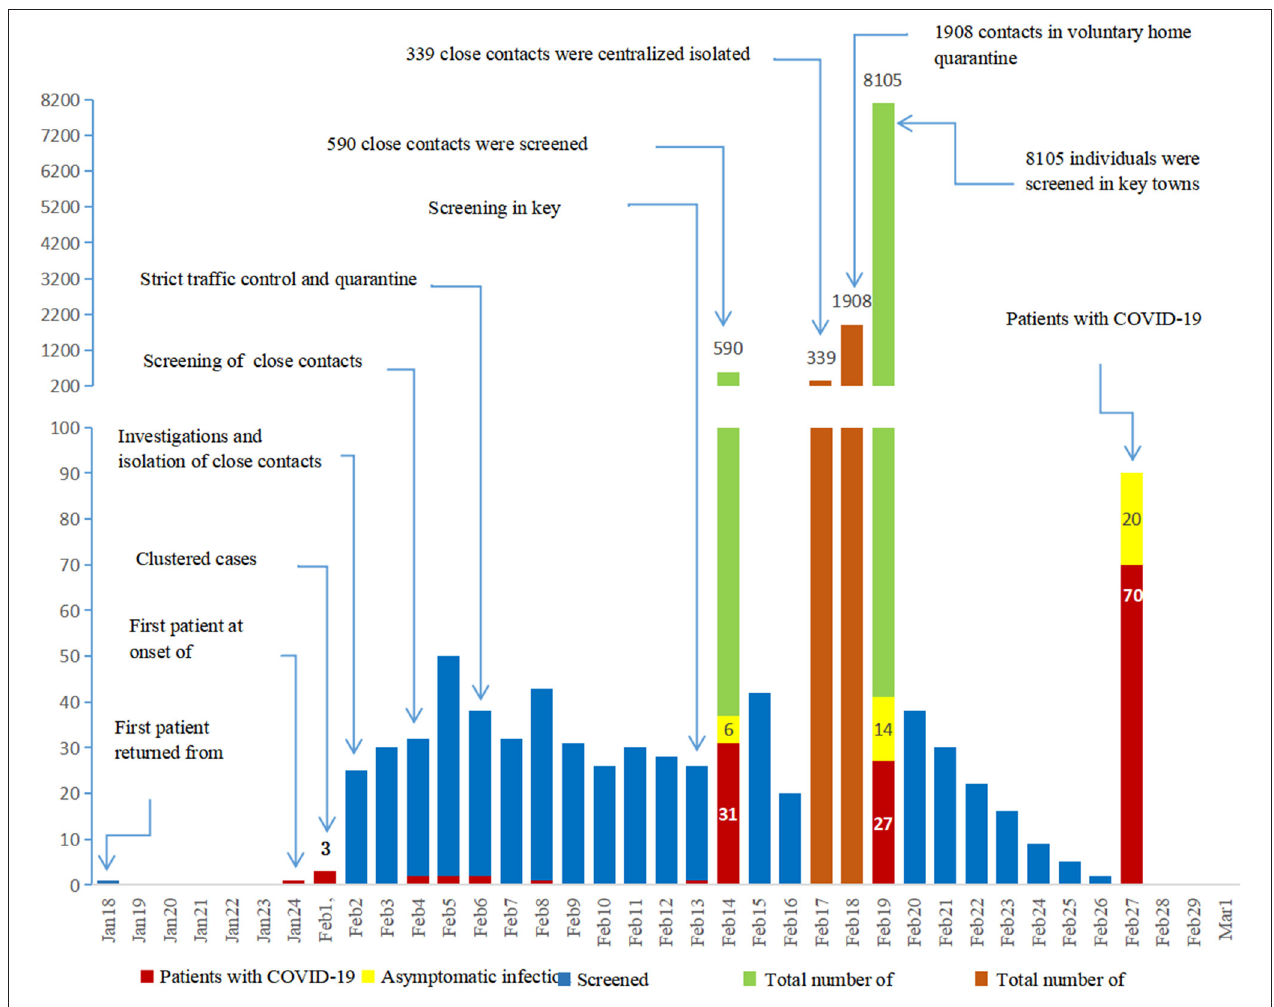
FIGURE 3 | Since the outbreak of COVID-19, isolation, quarantining and active screening have been implemented. In total, 8695 close contacts were actively screened with